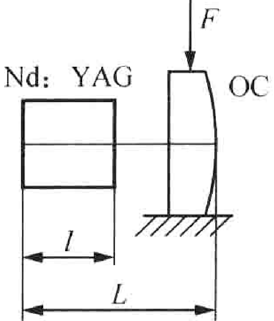
Figure 17. Schematic diagram of coupled-cavity dual-frequency Nd:YAG laser [28] . OC: output coupler.